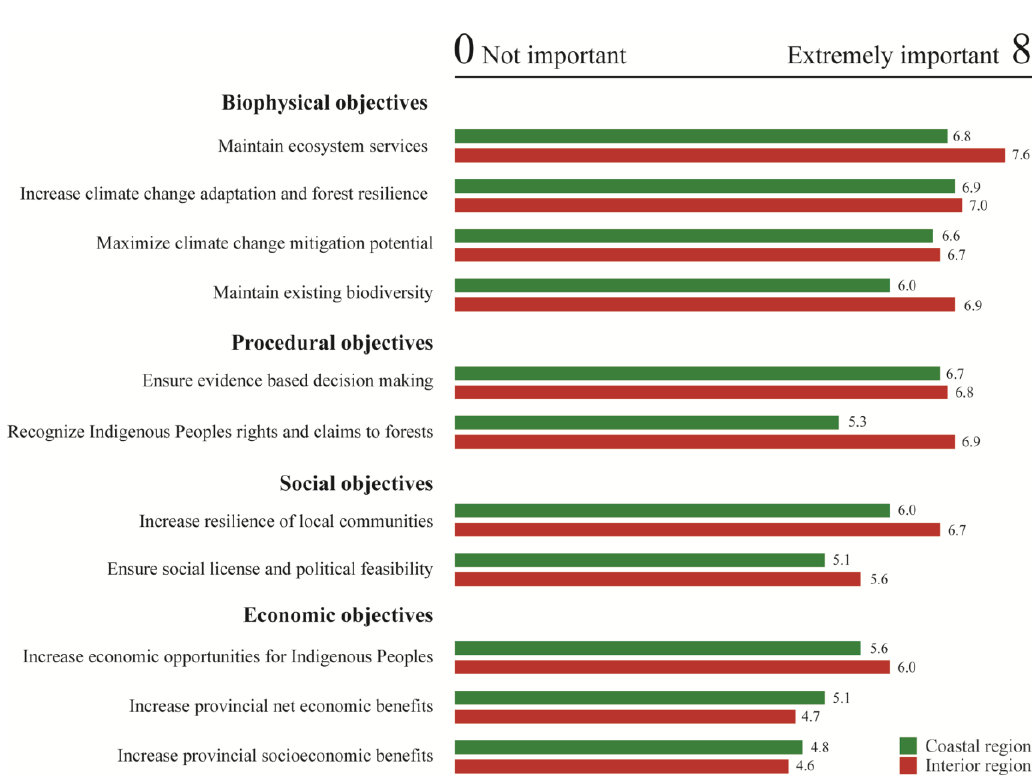
Figure 5. Weight of the objectives for the coast and the interior regions, where 0 = not at all important and 8 = very important.